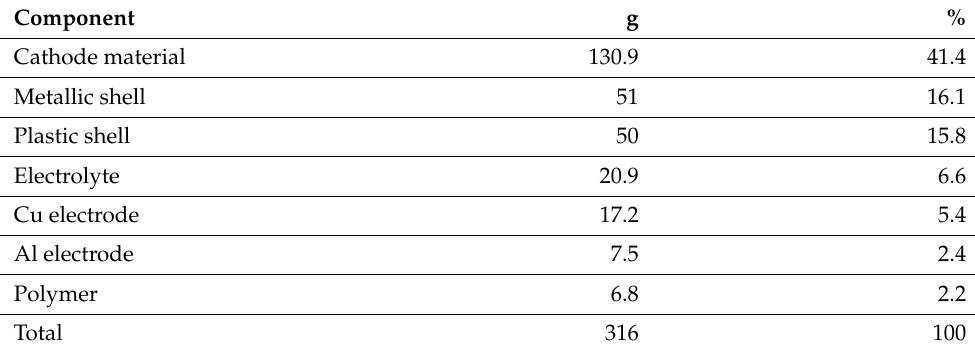
Table 3. The weight percentage of Li in each part of LIB material